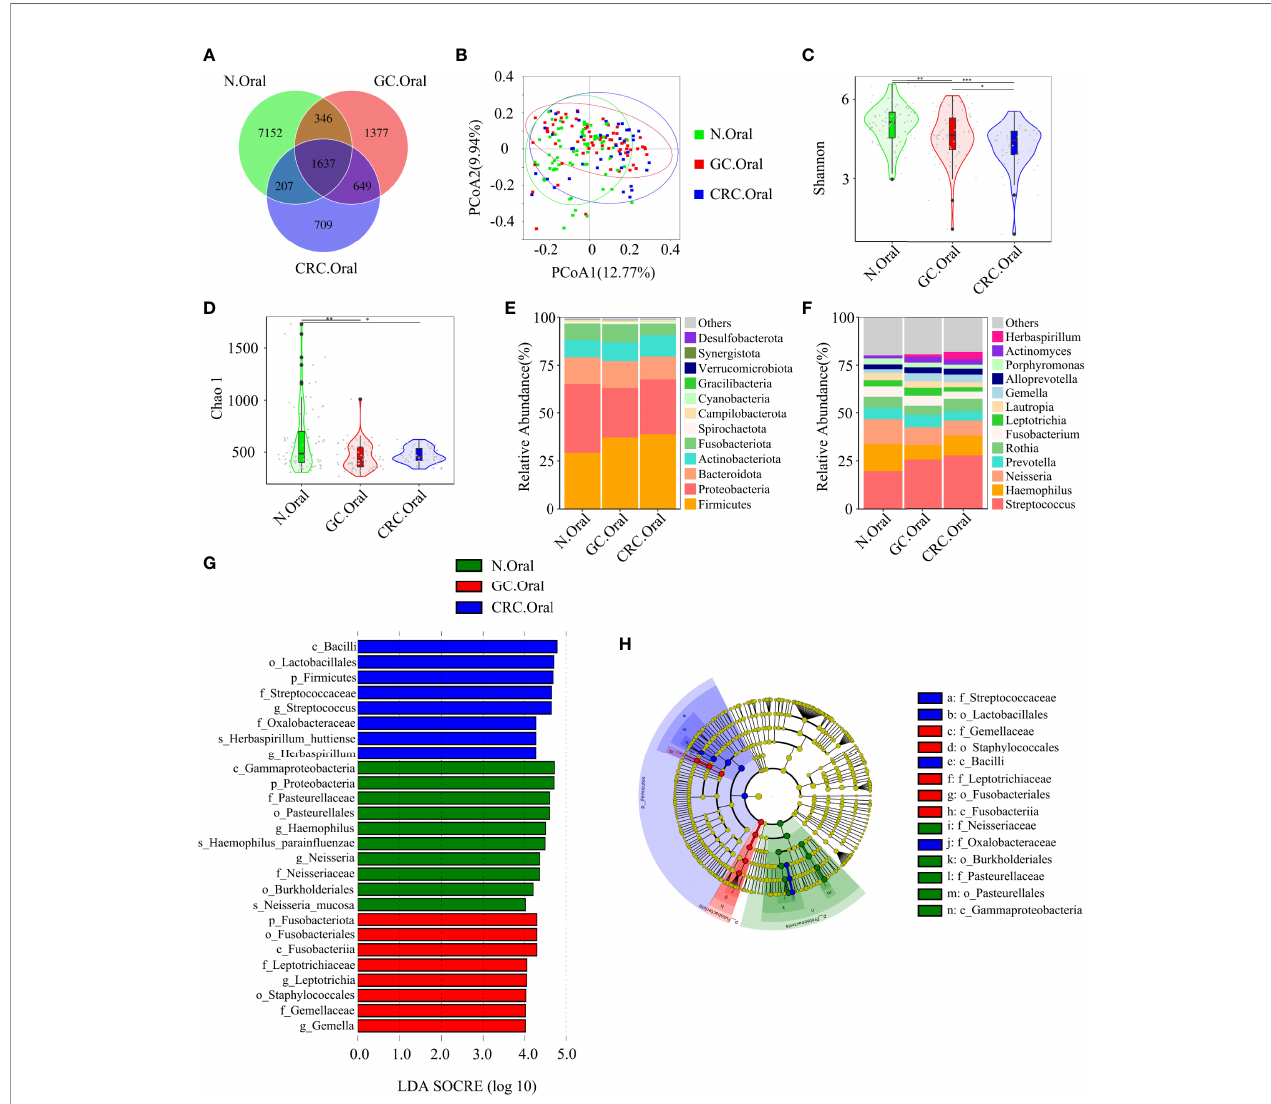
FIGURE 3 | Compared with the HC ( n = 70), the oral microbial diversity of patients with GC ( n = 70) and CRC ( n = 42) was reduced. (A) The Venn diagram displayed the overlaps among groups, showing a total of 12,077 OTUs. (B) PCoA calculated b -diversity on a distance (dissimilarity) matrix of Bray – Curtis indexes. The Shannon index (C) and Chao1 index (D) were used to evaluate the oral microbial diversity of patients with HC, GC, and CRC. Composition of oral microbiota at the phylum level (E) and genus level (F) among the three groups. The linear discriminant analysis (LDA) effect size (LEfSe) method was used to analyze the speci fi c characterization of the oral microbiota of patients with HC, GC, and CRC. (G, H) The LEfSe method identi fi ed the most divergent taxa in GC and CRC and scored the two groups of oral samples by LDA. Only the taxa that reach the effective threshold of LDA >4 were displayed. The brightness of each point was proportional to the size of its effect. * p < 0.05, ** p < 0.01, *** p < 0.001; OTUs, operational taxonomy units; PCoA, principal coordinate